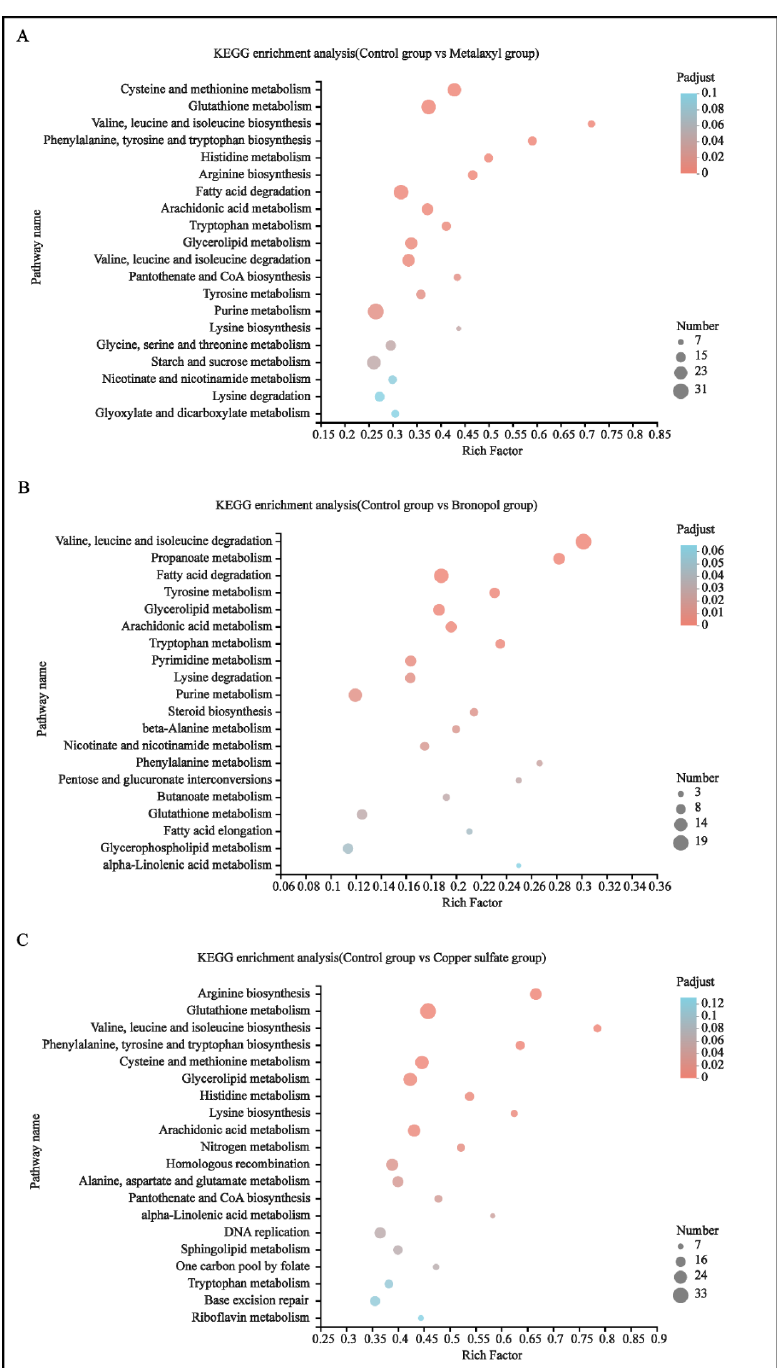
Figure 5. DEGs of control vs. metalaxyl ( A ), control vs. bronopol ( B ) and control vs. copper sulfate groups ( C ) were assigned to KEGG pathway annotations. The top 20 enriched KEGG pathways are presented in the figure.